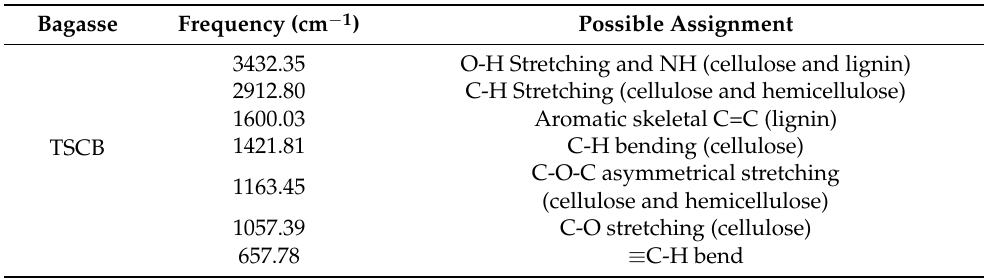
Table 4. FTIR characteristics of